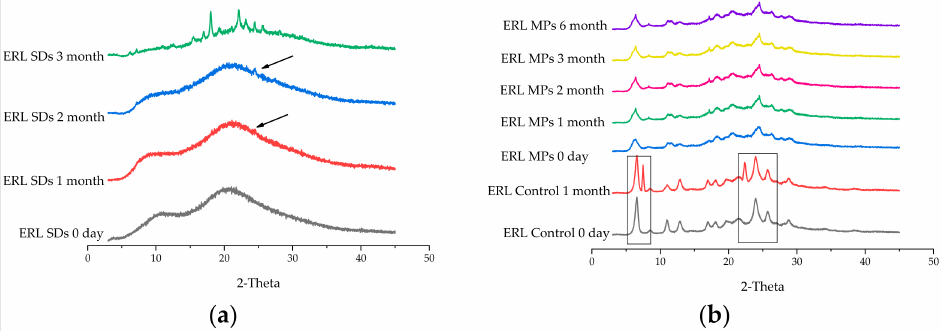
Figure 9. PXRD patterns of ( a ) ERL SDs and ( b ) ERL MPs stored at 40 ◦ C/75%